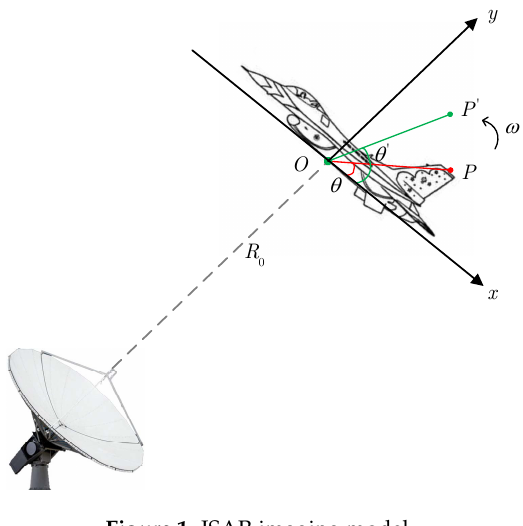
Figure 1. ISAR imaging